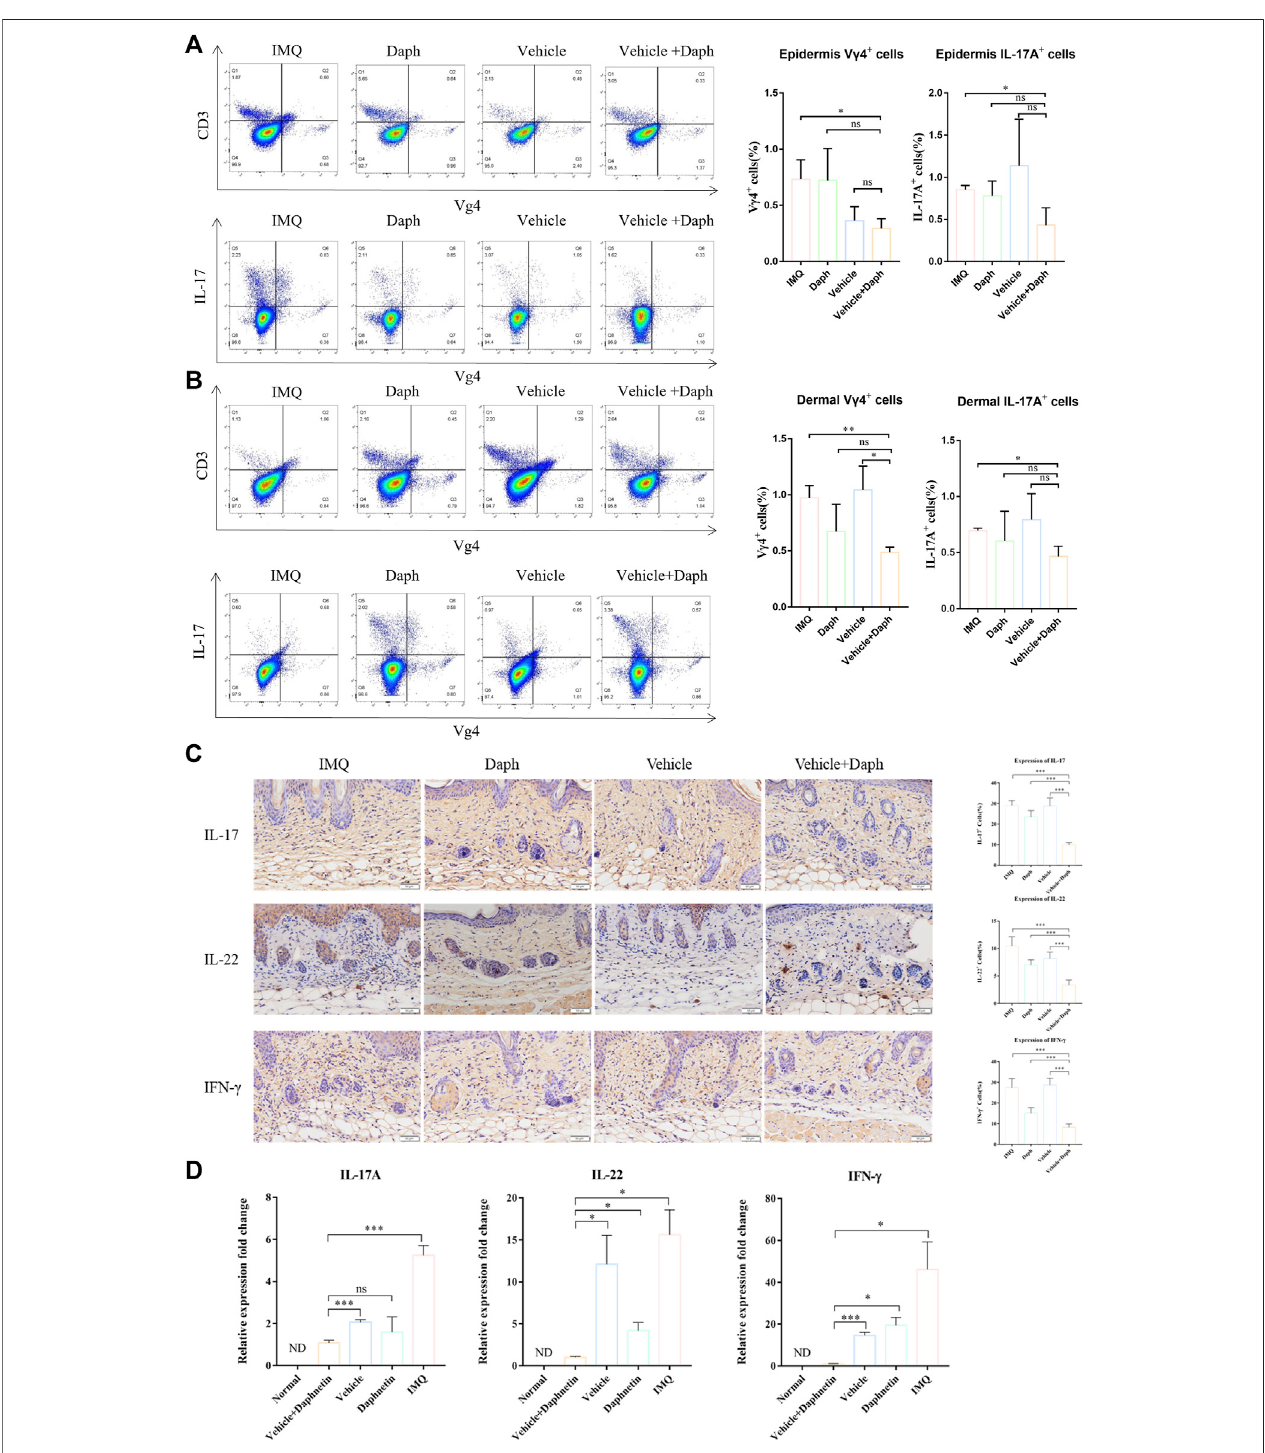
FIGURE 6 | Proportion of V γ 4+T cells and secretion of in fl ammatory factors in the skin at the modeling site were detected. (A,B) Proportion of V γ 4+T cells and the proportionofIL-17-secretingcellsinthedermisand epidermisweredetected by fl owcytometry. (C) Immunohistochemicalstainingofmajorin fl ammatory factors(IL-17, IL-22, and IFN- γ ) secreted by keratinocytes and the expression of in fl ammatory factors were counted by the proportion of positive cells. (D) PCR detection results of skin-related in fl ammatory factors (IL-17, IL-22, and IFN- γ ) at the mouse modeling site. Data are shown as mean ± SE (* p < 0.05; ** p < 0.01).